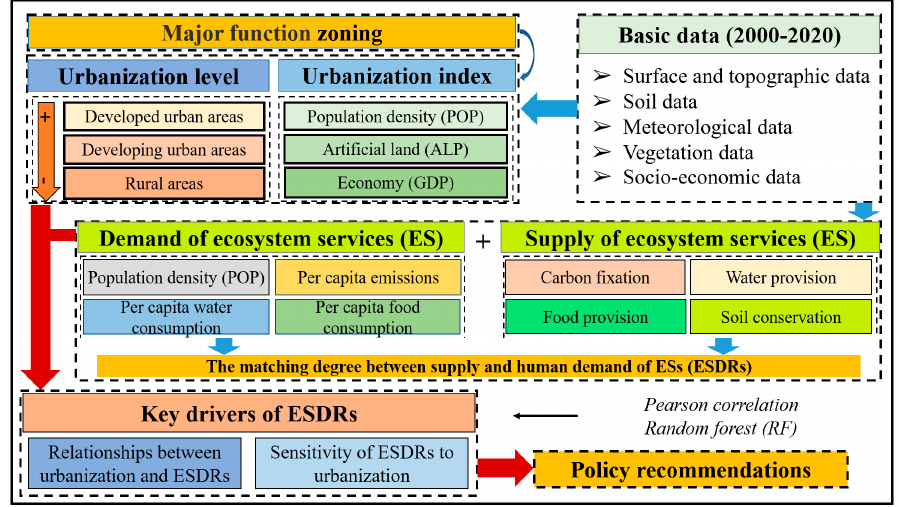
Figure 1. The framework and procedures of this study.